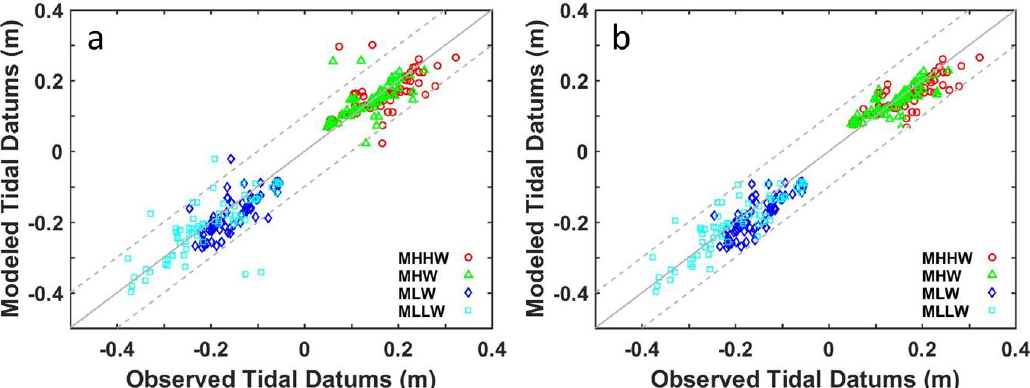
Figure 7. Modeled tidal datums vs observed tidal datums before ( a ) and after ( b ) model adjustments. The dashed lines represent 0.10 m error limits.